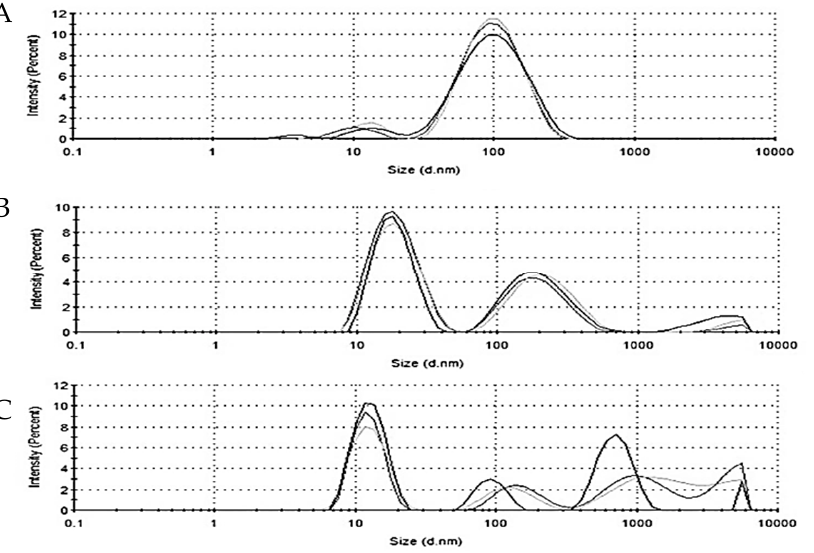
Figure 3. Hydrodynamic diameter of ( A ) P. aliciae gold nanoparticles (AuNP PAE ), ( B ) rosmarinic acid gold nanoparticles (AuNP RA ), and ( C ) tetracycline gold nanoparticles (AuNP TET ), n = 3.